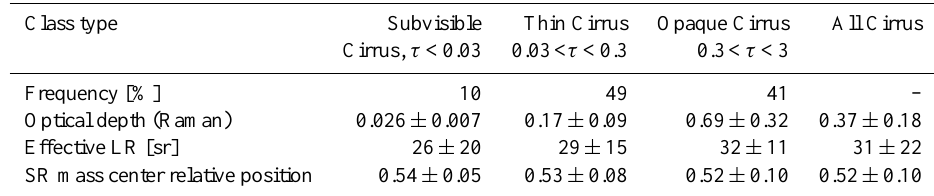
Table 5. Frequency, mean optical depth (Raman method), effective lidar ratio (LR) and backscattering mass center relative position for the subsample of cirrus data set discretized following Sassen and Cho (1992) classification